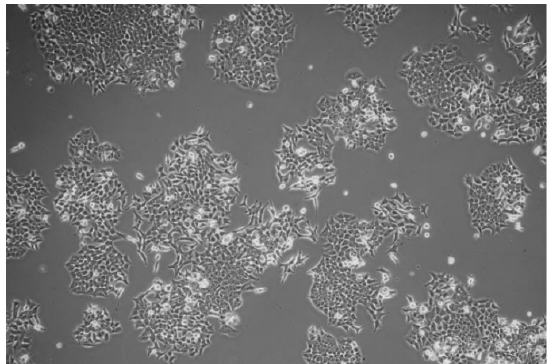
Figure 10. Standard cell culture of the HCT116 cells (sample 1—chitosan crosslinked with adipic and malonic acid; sample 2—chitosan crosslinked with adipic and L -glutamic acid; sample 3—chitosan crosslinked with adipic, L -glutamic and malonic acid; sample 4—chitosan crosslinked with adipic and levulinic).